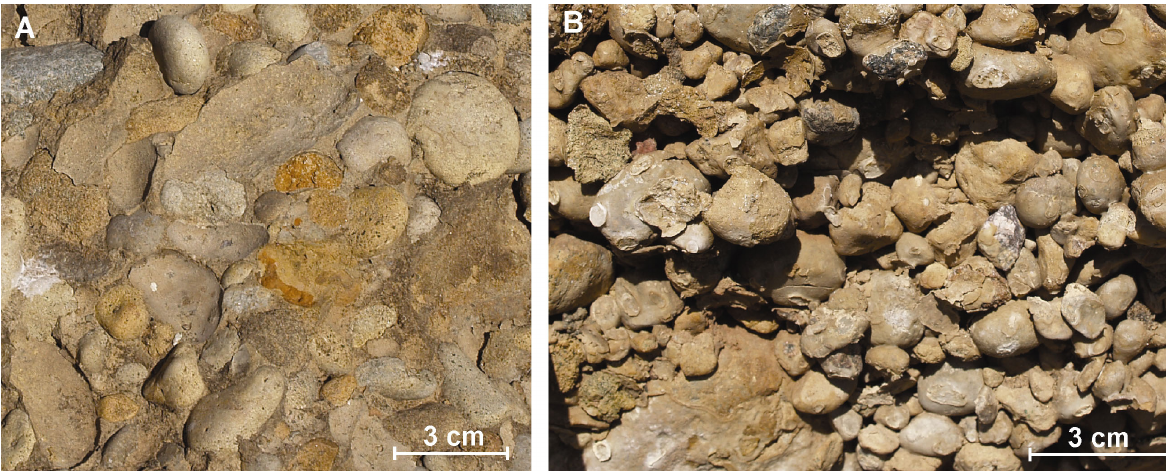
Fig. 5. Texture of the cement. A , uniformly-cemented fine-grained material between coarser clasts; B , cement crust between well- sorted porous coarse